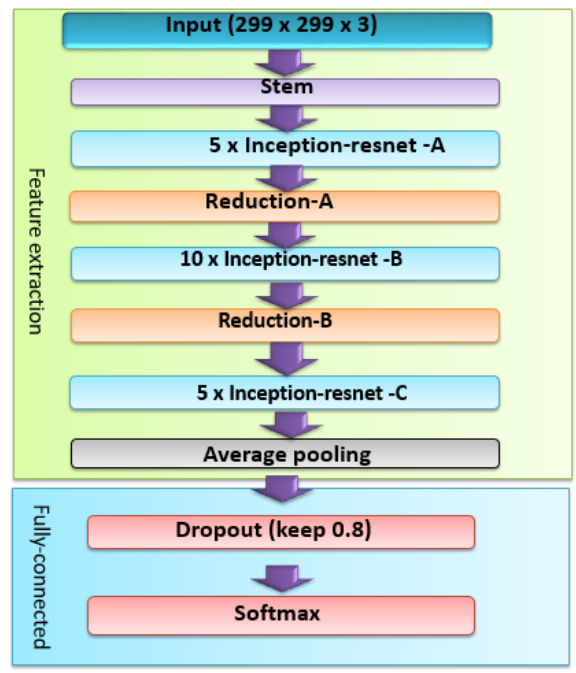
Figure 4. Overall scheme of the InceptionResNetv2